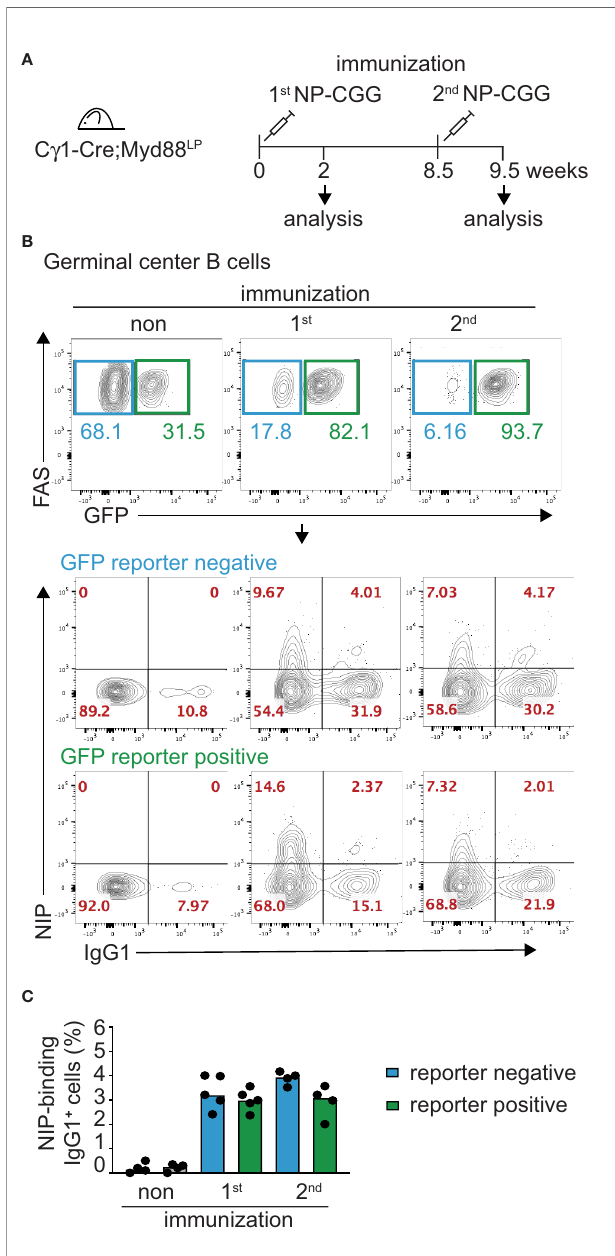
FIGURE 2 | Myd88 L252P -expressing B cells switch isotype normally. The Myd88 L252P allele was crossed into the B-cell-speci fi c C g 1-Cre strain which activates Cre-expression in mature B cells upon germline transcription of the IgH C g 1 switch region. (A) C g 1-Cre;Myd88 L252P and littermate control animals were immunized with hapten carrier conjugate (NP-CGG) and analyzed at the indicated time points. (B) Representative fl ow cytometry plots of germinal center (GC) B cells (B220 + CD19 + CD38 low FAS high ). Upper panels: Myd88 L252P GFP-reporter-positive cells increased upon primary and secondary immunization. Lower panels: Antigen-speci fi c, reporter-negative and -positive GC cells switch to IgG1 to similar extents during primary and secondary immune responses. (C) Percentage of IgG1-positive, antigen- positive GC cells. Each dot represents one mouse (n ≥ 4). (See also Supplementary Figure 5